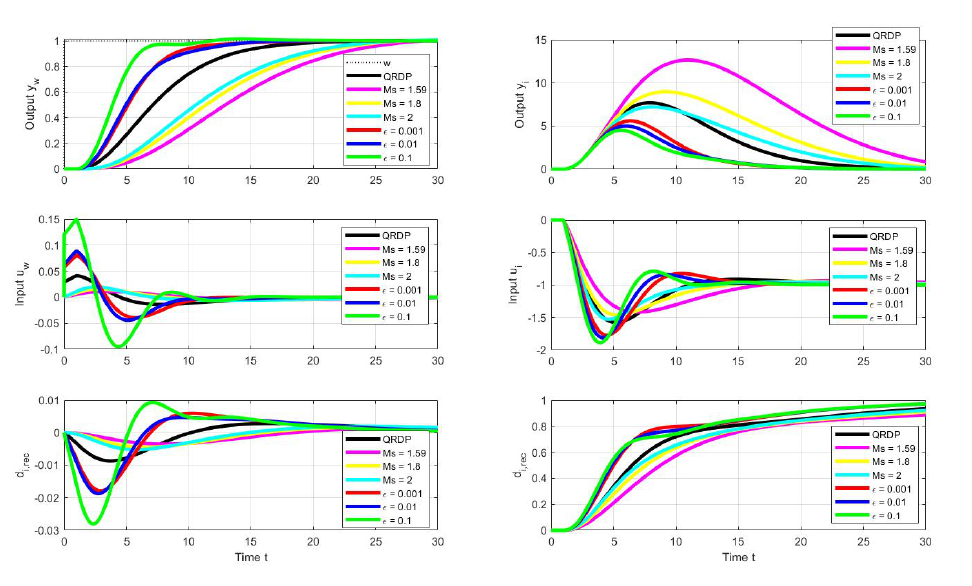
Figure 6. Unit setpoint step responses ( left ) and unit input disturbance step responses ( right ) achieved with the QRDP PID controller (black), responses corresponding to POI-PID controllers [44] with a prescribed M s constraints and responses corresponding to optimal tuning calculated by the PPM with the parameter grid (41) under the performance specifications (46) and (44); T m = 1; K s = 1; T s =